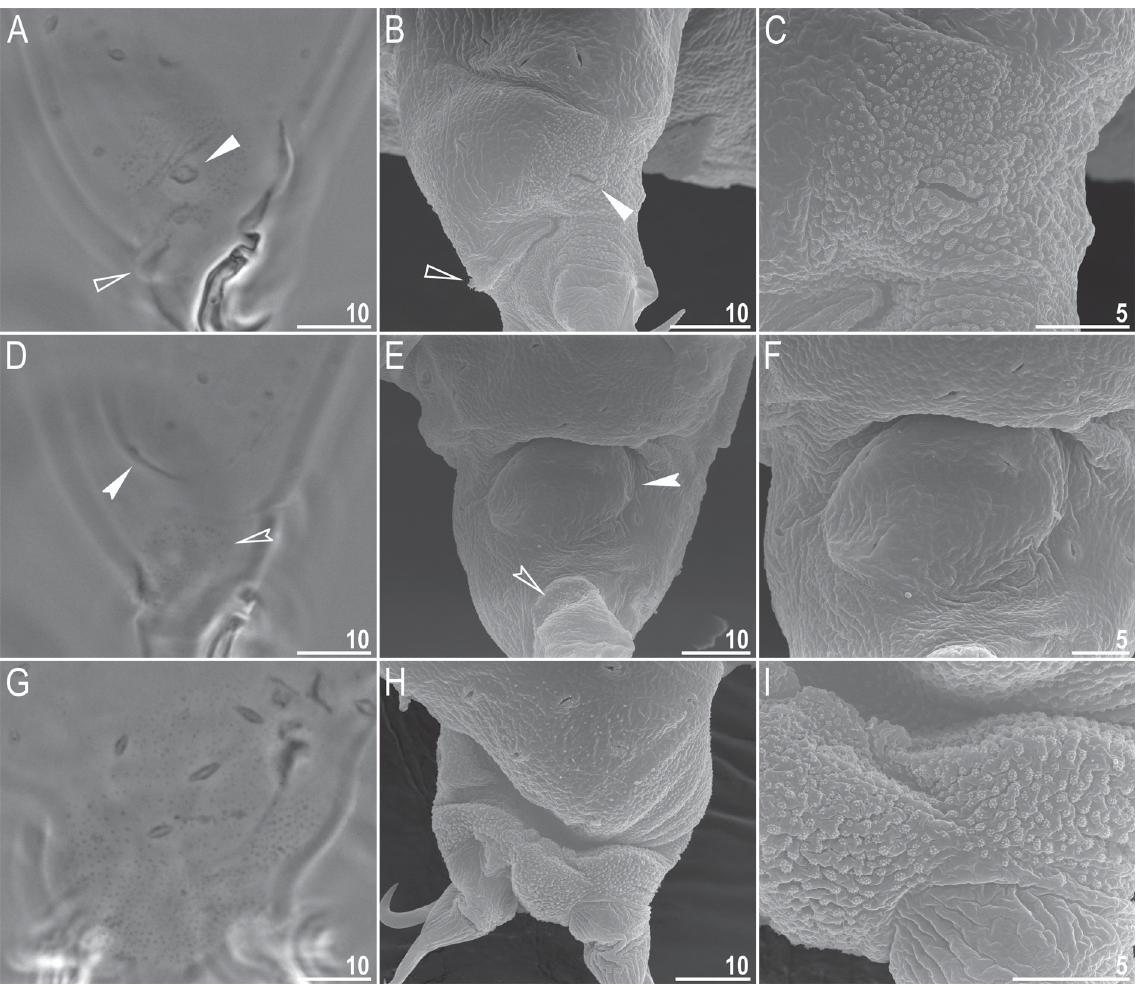
Fig. 9. Macrobiotus cf. recens Cuénot, 1932 , Gran Canaria, structures on forelegs seen under PCM and under SEM. A–C . The patch of granulation on the external surface of leg II, with the cuticular pore at the centre of the patch and the cuticular fold above the claws. D – F . The patch of granulation and the cuticular bulge (pulvinus) on the internal surface of leg III. G – I . Granulation on leg IV. Filled flat arrowheads indicate the large pore at the centre of the external granulation patch, empty flat arrowheads indicate the cuticular fold above the claws on the external leg surface, filled indented arrowheads indicate the cuticular fold (pulvinus) on the internal leg surface, and empty indented arrowheads indicate granulation on the internal leg surface. Scale bars in